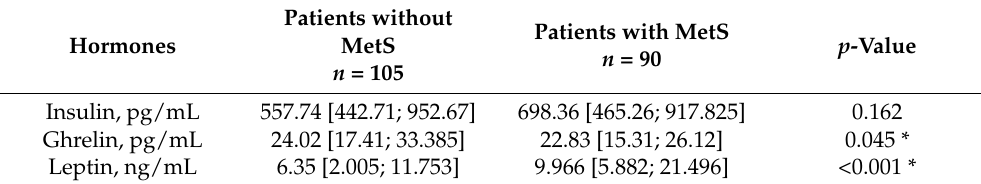
Table 3. Insulin, ghrelin, and leptin concentrations in blood serum of schizophrenia patients without and with metabolic syndrome (Me [Q1; Q3]).